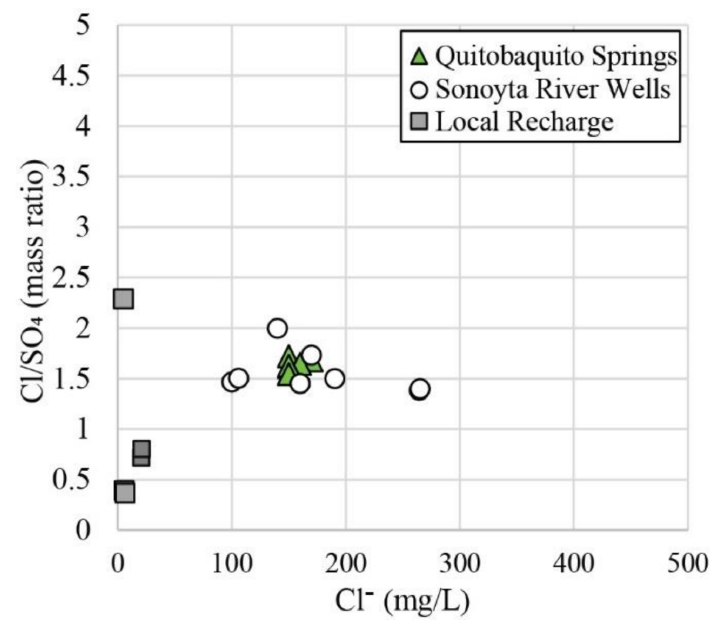
Figure 14. Cl / SO 4 vs Cl − concentrations for local recharge (sites 1, 12, 13, 27, and 28), Quitobaquito (sites 3, and 4), and Sonoyta River wells upstream of Quitobaquito (sites 7, 8, 10, 17, 18, and